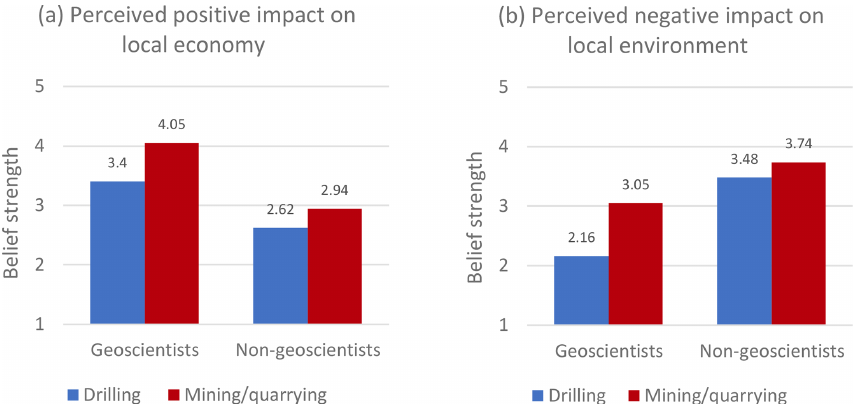
Figure 3. Perceived economic and environmental impact. (a) Mean scores in answer to beliefs on the extent to which they agreed that drilling and mining/quarrying would improve the local economy. (b) Mean scores in answer to beliefs on the extent to which they agreed that drilling and mining/quarrying would have a negative impact on the local natural environment; measurements are on a scale from 1 (totally disagree) to 5 (totally